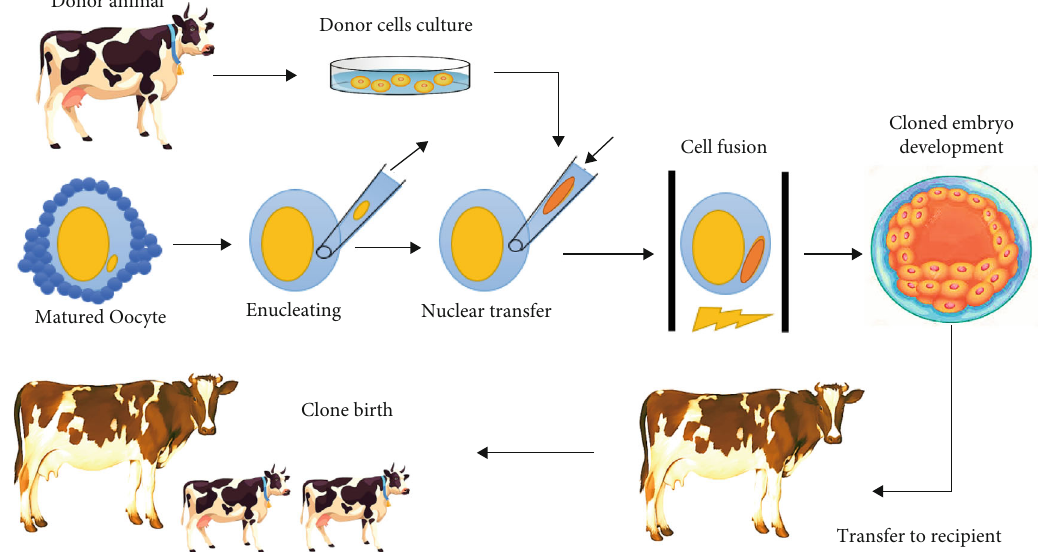
Figure 4: SCNT process